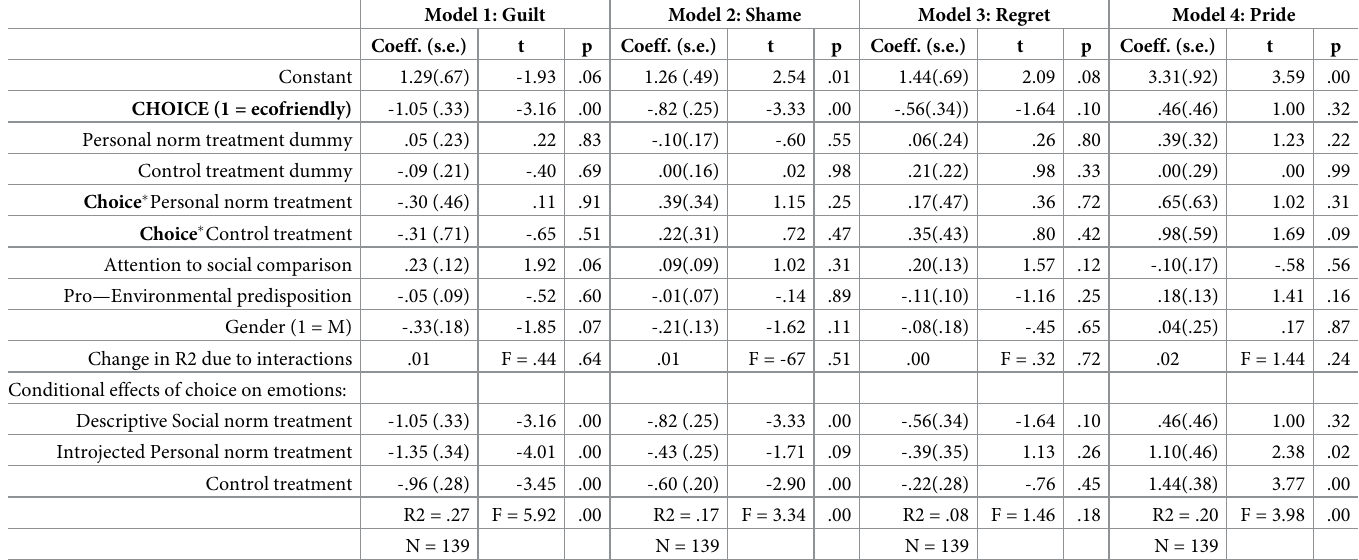
Table 4. Conditional linear regressions of chosen product on emotions, moderated by